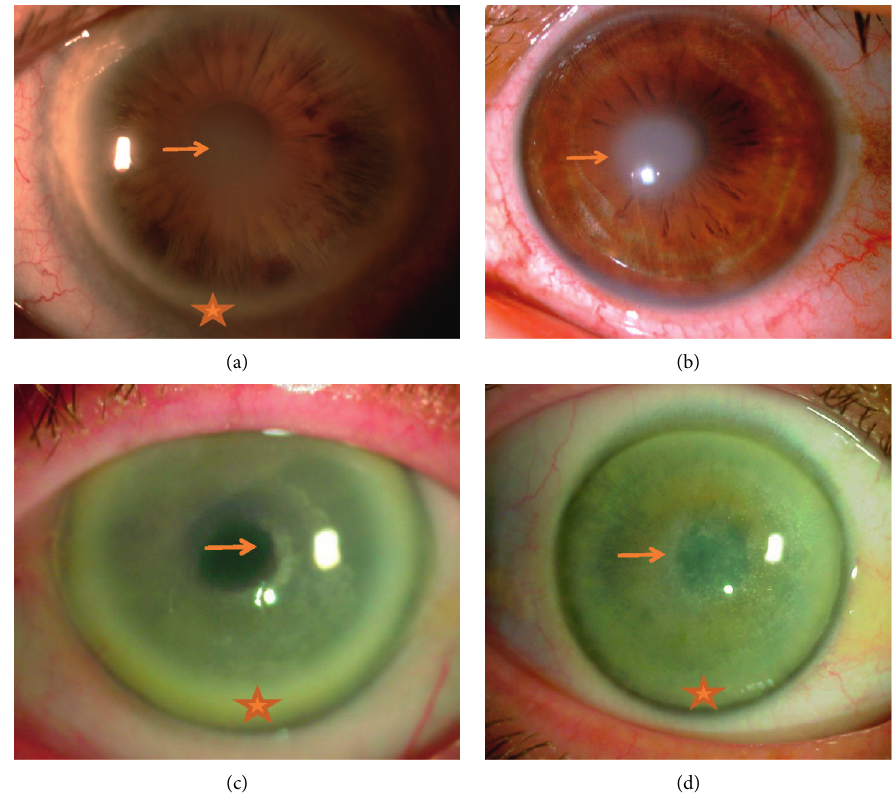
Figure 1: Slit-lamp photographs of Schnyder corneal dystrophy patients showing central opacities (arrows), midperipheral stromal haze, and peripheral arcus lipoides (stars) in most patients. Corneal crystals were less frequently observed. (a) Patient #1, central stromal opacity with arcus lipoides. (b) Patient #4, arcus lipoides was absent in the youngest patient. (c) Patient #6, central opacities with diffuse crystals and Table 1: Clinical data, slit-lamp finding, and pachymetry of seven eyes of seven patients with Schnyder corneal dystrophy. Patient and eye